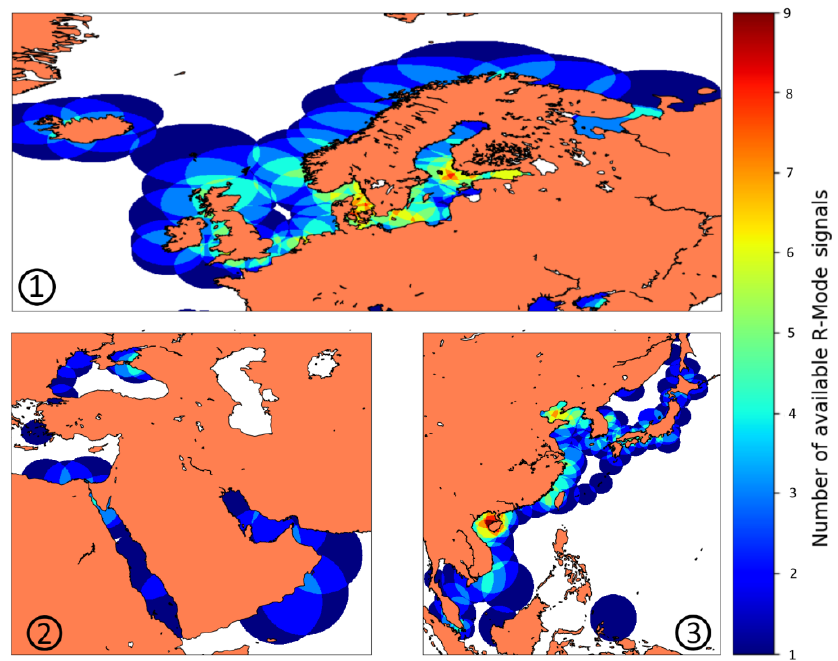
Figure 5. Potential R-Mode service area: ( 1 ) North Europe; ( 2 ) Black Sea, Suez, Red Sea and Gulf of Oman and ( 3 ) Coast of China and Japan.